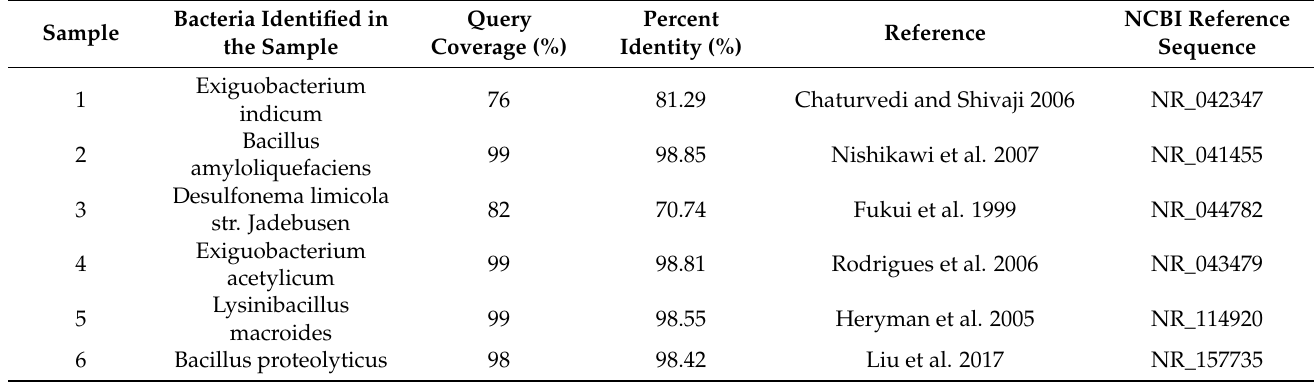
Table 2. The result of bacteria identification based on Sanger sequencing and nucleotide sequence database using BLASTn program.